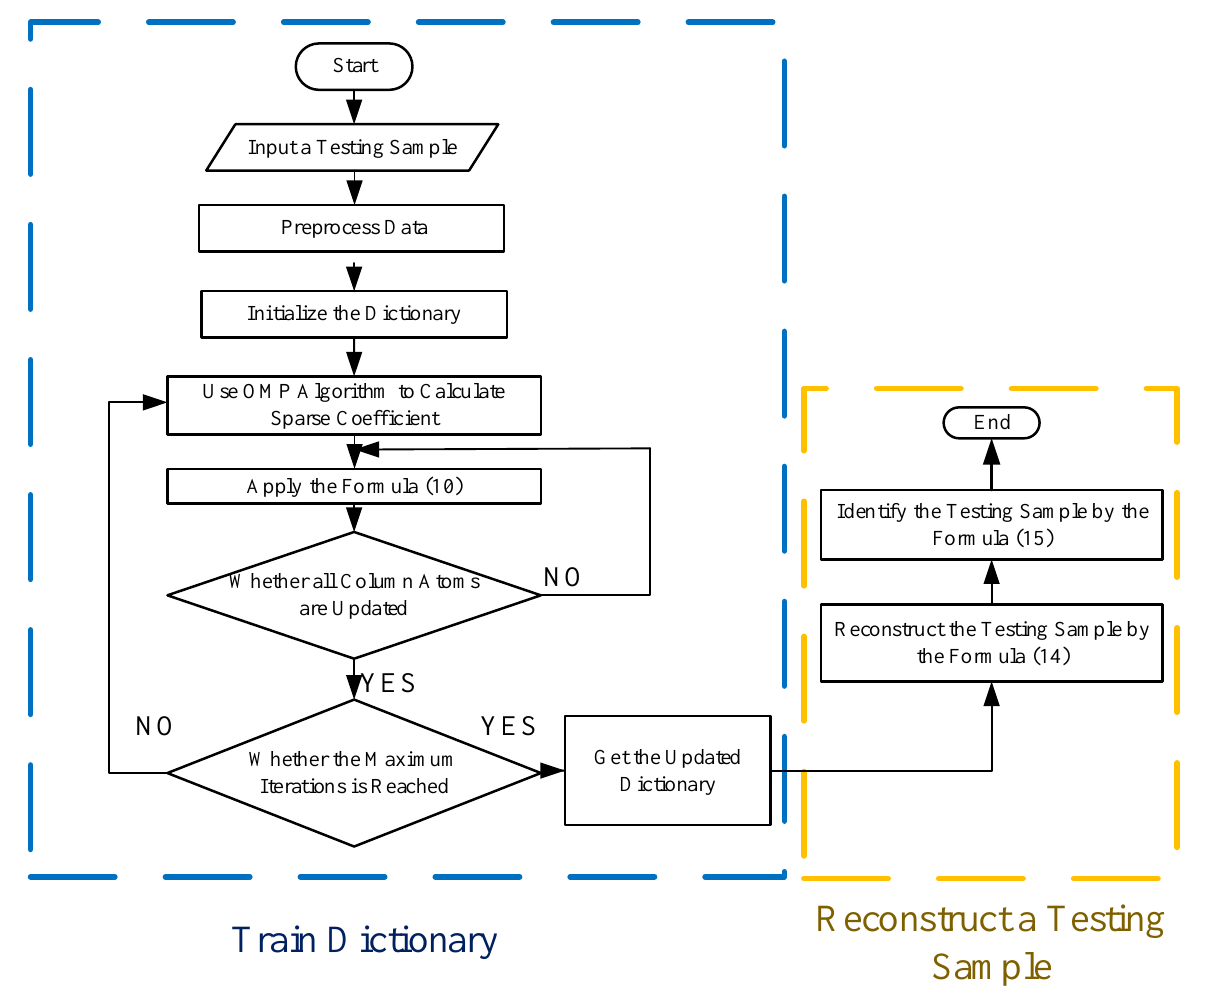
Figure 7. The flowchart of the improved algorithm.